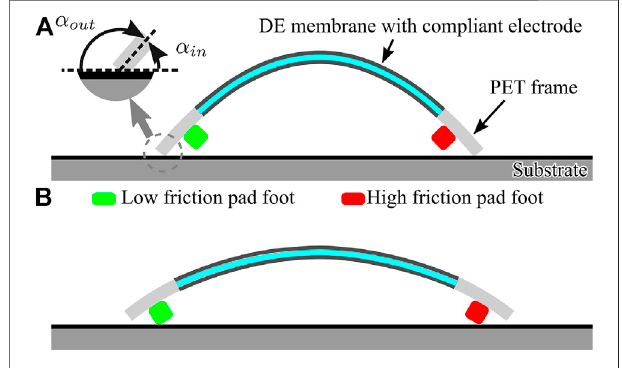
FIGURE 2 | Soft inchworm crawler structure showing two typical body- shape changes and the resulted substrate-contacting statuses. (A) Short- length state with body ends contacting the substrate and (B) Long-length state with pad-feet contacting the substrate.